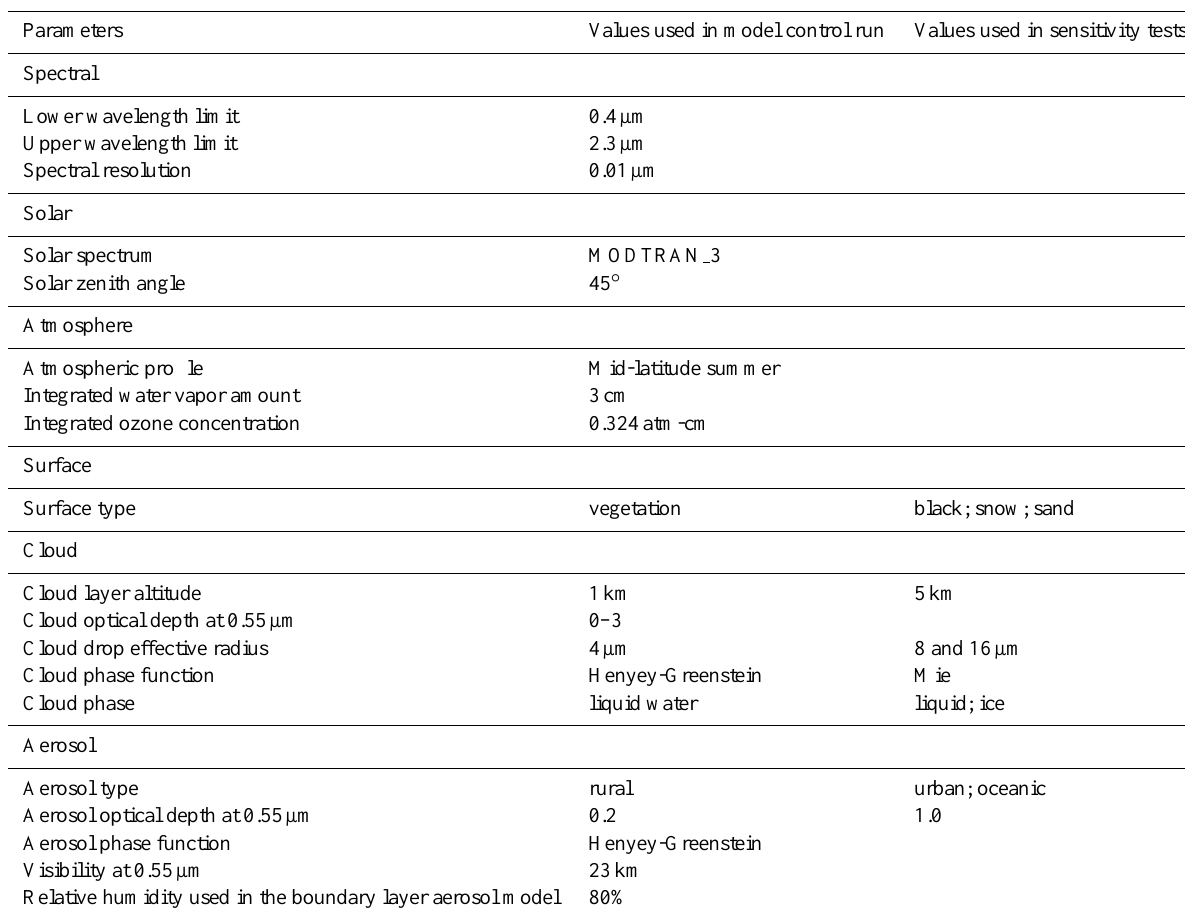
Table 1. SBDART input parameters used in the control run and sensitivity